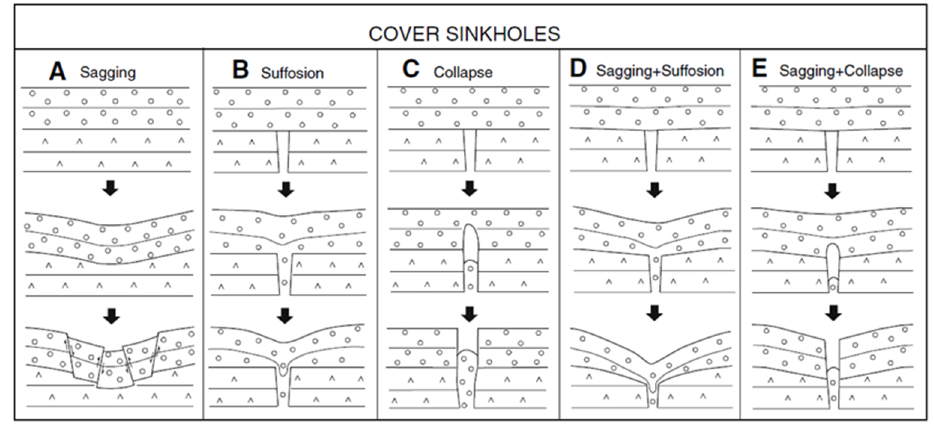
Figure 1. Diagram showing the main subsidence mechanisms involved in the generation of sinkholes. cover